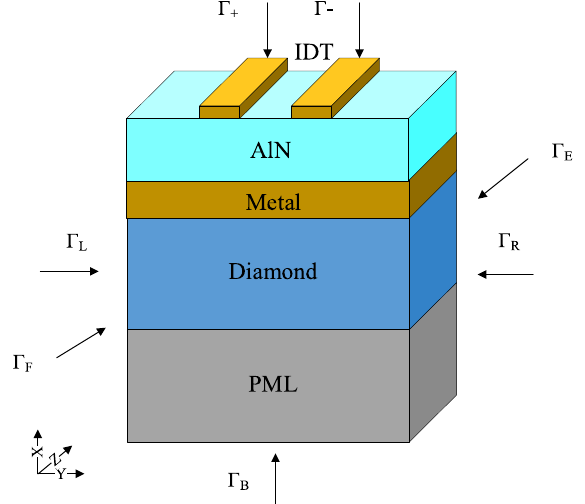
Figure 1. Quasi-3D periodic FEM model used in the simulation (not to